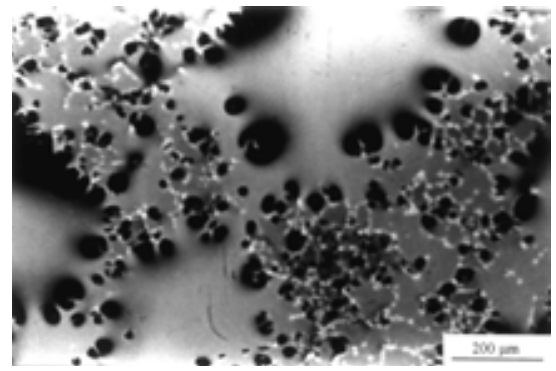
Figure 4. Optical micrograph of expelled glass phase on YSZ ceramic after 8.0 h of sintering at 1610 °C.